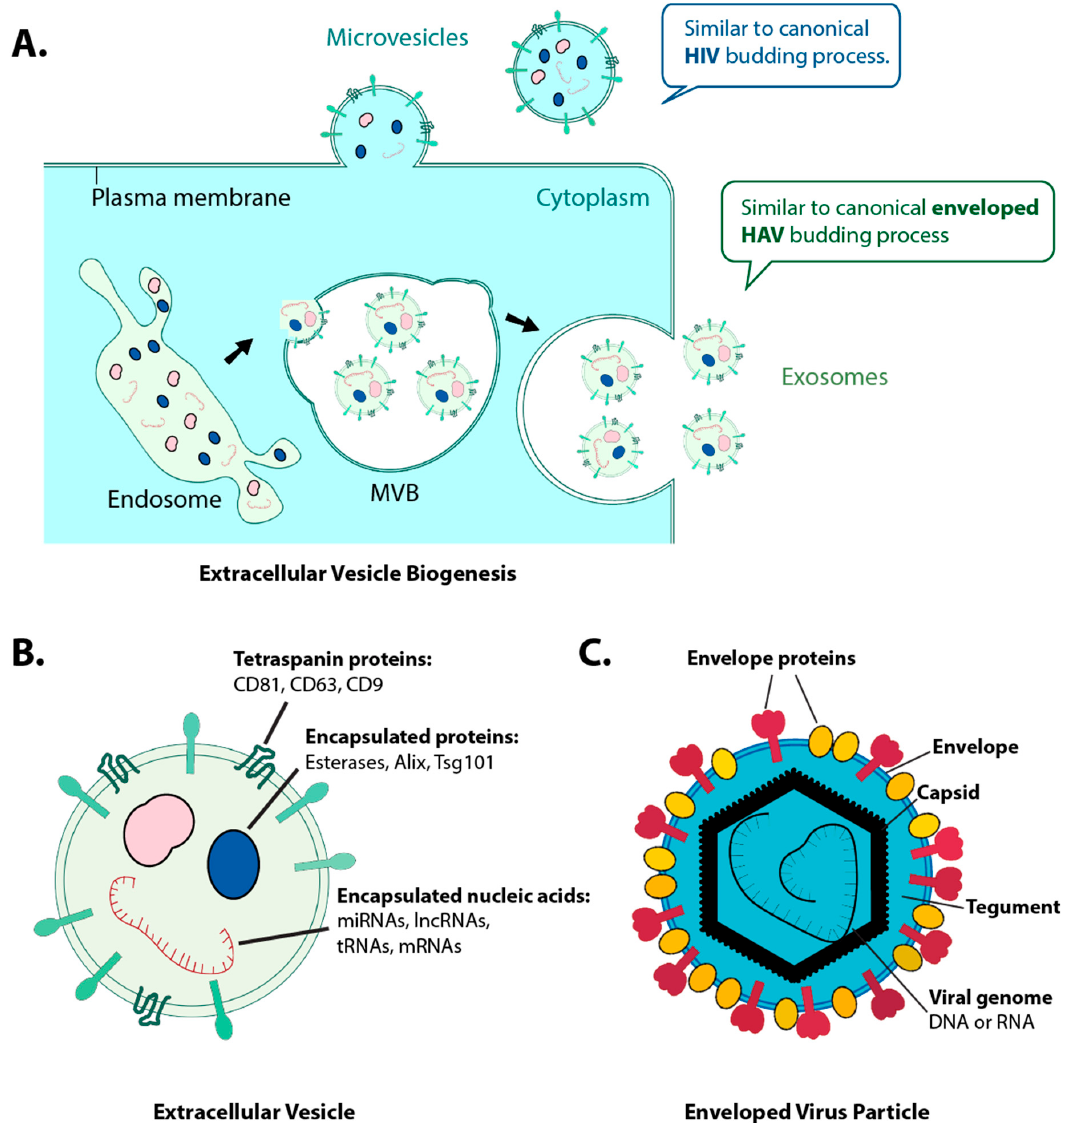
Figure 1. Extracellular vesicles (EV) and virus particles share similar vesicular budding process and composition, including proteins, nucleic acids, and lipids. ( A ) Microvesicles bud off at the plasma membrane, similar to the canonical human immunodeficiency viruses (HIV) budding process. Exosomes originate from inward budding of the late endosome into multivesicular body (MVB) and later release at the plasma membrane, similar to the canonical enveloped hepatitis A viruses (HAV) budding process. ( B ) Extracellular vesicles may carry makers like tetraspanins, esterases, Alix, and Tsg101 [1] . The encased nucleic acids are protected from nucleases. ( C ). A virus particle consists of an envelope, capsid, tegument, and viral genome.